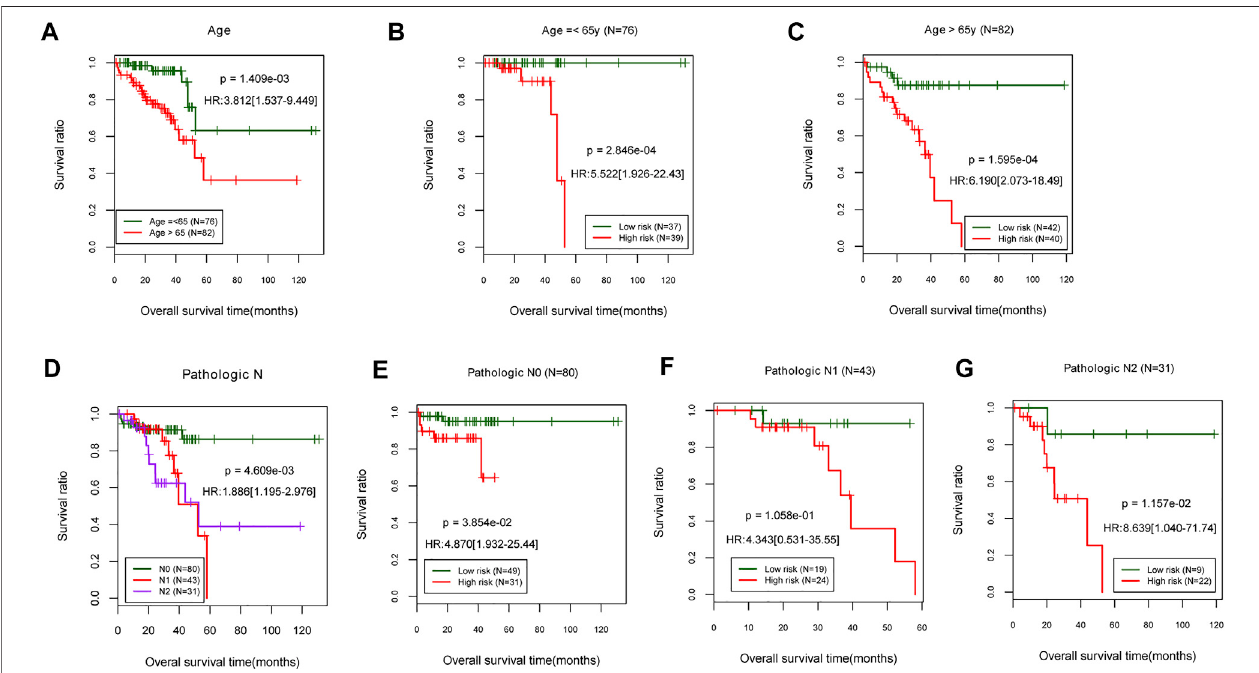
FIGURE 5 | Strati fi ed analysis on age and pathologic. (A) Age-related prognostic Kaplan – Meier curve. (B,C) Prognosis-related Kaplan – Meier curves in TCGA samples for patients aged 65 and younger. (D) Prognostic-related Kaplan – Meier curve of pathologic stage. The pathologic stages N0, N1, and N2 are represented in TCGA sample ’ s prognosis-related Kaplan – Meier curve chart (E – G) . TCGA, The Cancer Genome